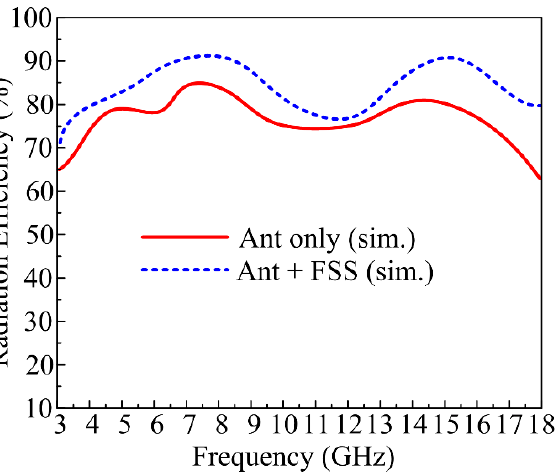
Figure 11. Simulated radiation efficiency of suggested UWB antenna with and without FSS.